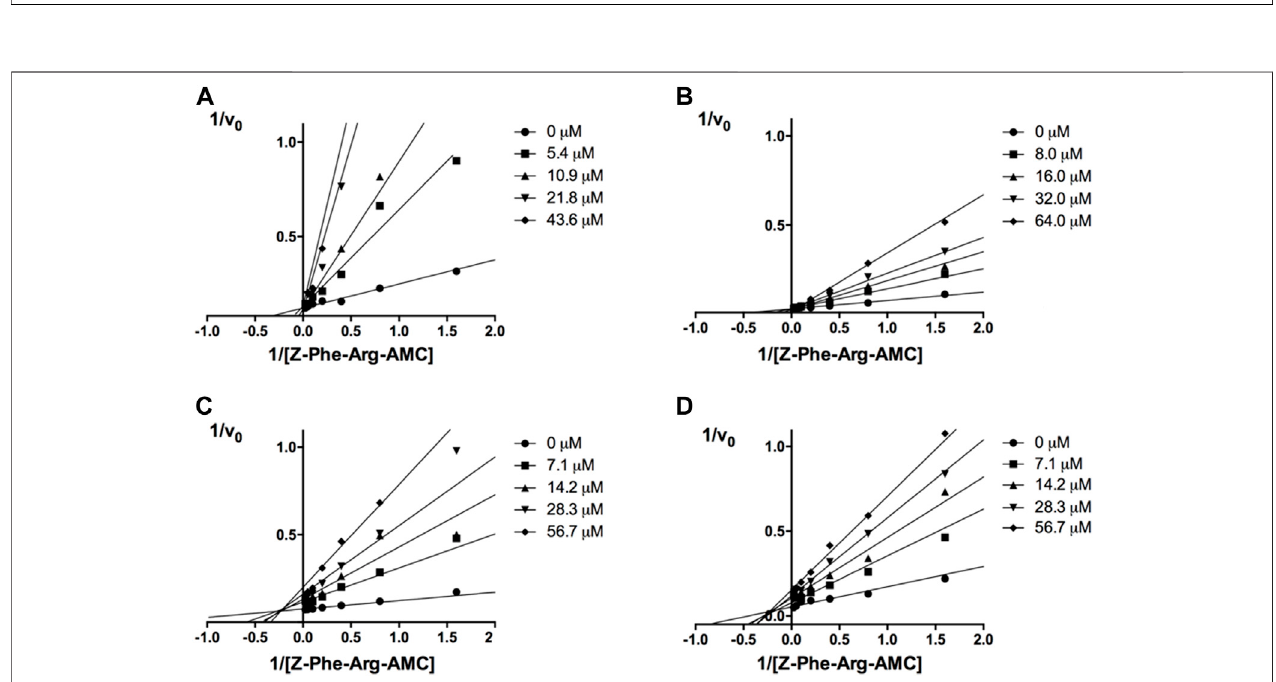
FIGURE 3 | Lineweaver-Burk plots for compounds 1 (A) ; 25 (B) ; 27 (C) ; and 26 (D) . Each curve represents a different inhibitor